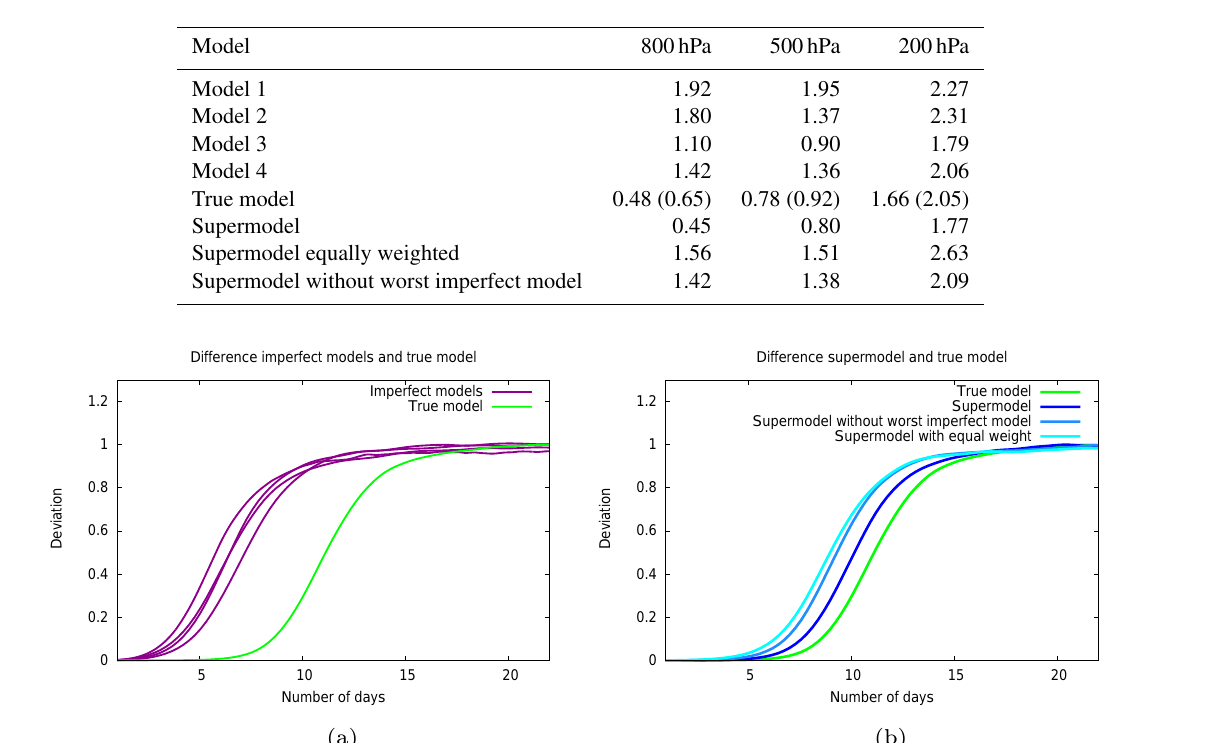
Table 7. The root mean squared error of the wind strength (ms − 1 ) over 900 winter days. For the true model, the average RMSE is given. The value for which 95% of the RMSE values is below that value is given in brackets.